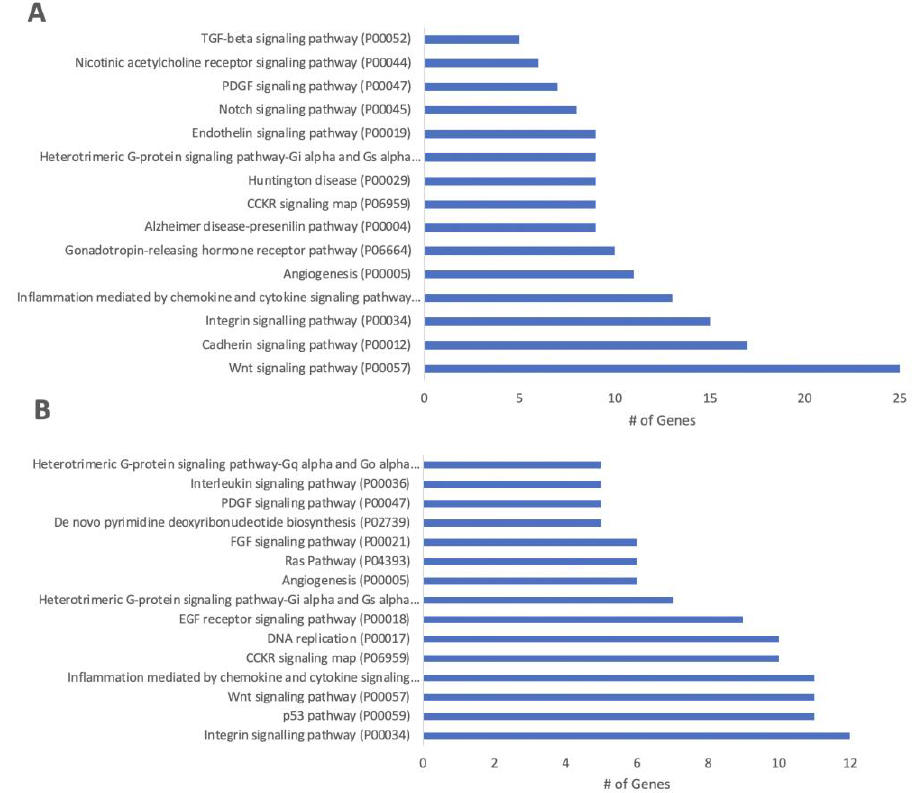
Figure 5 . Upregulated ( A ) and downregulated ( B ) enriched pathways of high vs. low density hiPSC- NPC cultures. Expression was determined relative to low-density cultures. The number of genes were determined from PANTHER analysis .